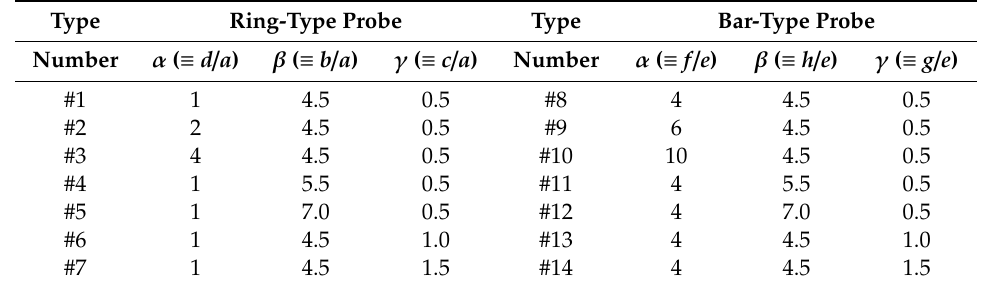
Table 1. Simulation conditions with various α , β , γ , and probe diameters. Parameters a–g are given in Figure 1. Type Ring-Type Probe Type Bar-Type